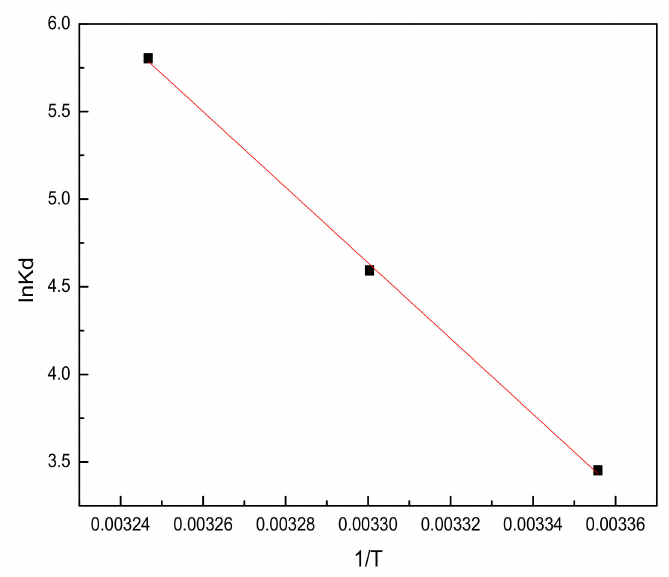
Figure 13. Effect of temperature on the adsorption of sulfonated lignite by filter paper-templated Mg-Al metal oxides (initial sulfonated lignite concentration: 350 mg/L; adsorbent dosage: 0.015; initial pH: 7; stirring time: 12 h).